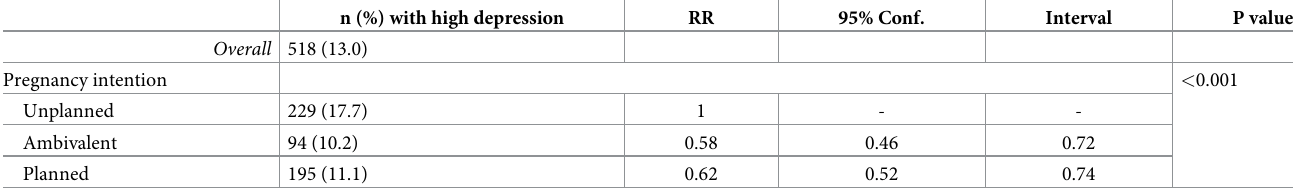
Table 4. Univariate regression of pregnancy intention and high symptoms of depression. n (%) with high depression RR 95% Conf.